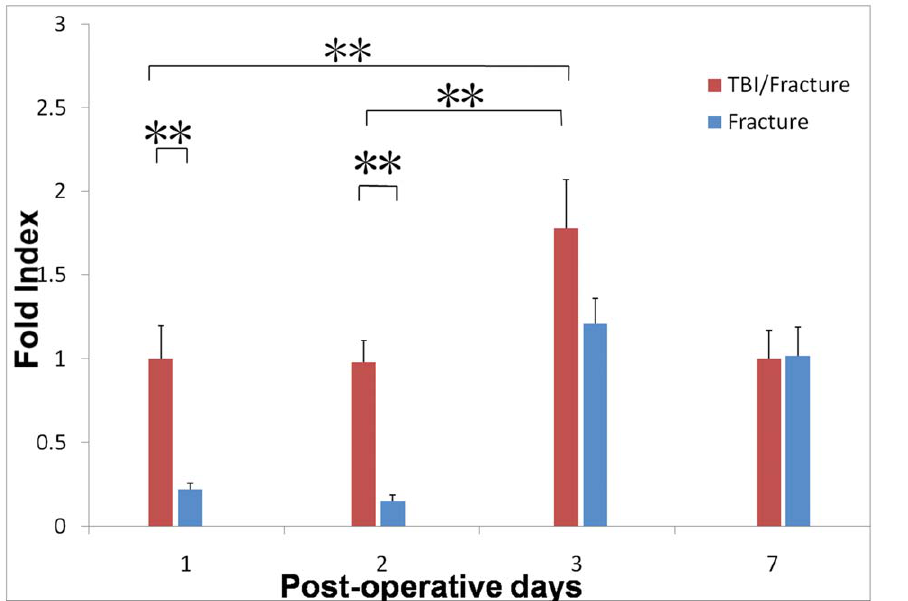
Figure 4. Time course of CXCR4 mRNA expression in TBI/fracture and fracture only models, as analyzed by real-time quantitative polymerase chain reaction (PCR) (n=4 at each time point). CXCR4 mRNA expression increased by 4.8-fold on day 1 in the TBI/fracture group compared with that in the fracture group ( P , 0.001), and further increased by 6-fold on day 2 ( P , 0.001) and nearly 1.5-fold on day 3 ( P , 0.001). Expression levels are the fold index versus the day 1 level in TBI/fracture only model. Values are the mean and SD results from triplicate real-time PCR analyses (*P , 0.05; **P , 0.001).